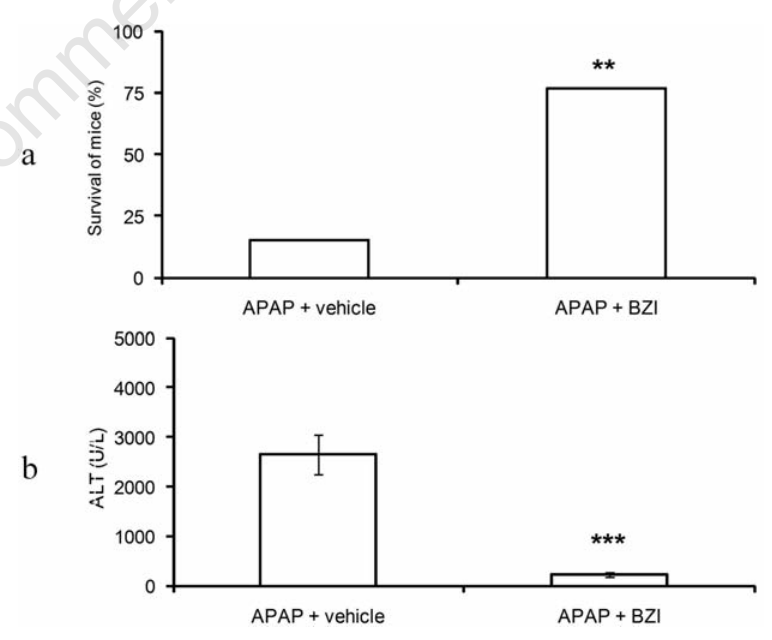
Figure 4. Effect of BZI on survival and plasma ALT concentration in mice with APAP- induced liver injury. (A) APAP (300 mg/kg) was given by oral gavage and survival was recorded 48 h later. BZI (50 mg/kg, i.p.) and vehicle were given 2 h after APAP adminis- tration. N=13 mice per group. **P<0.01 in comparison to vehicle group. (B) To determine the plasma ALT concentration, mice were treated as in the previous experiment, except that mice received a lower dose of APAP (150 mg/kg). Results represent mean±SEM of 10 mice per group. ***P<0.001 in comparison to vehicle